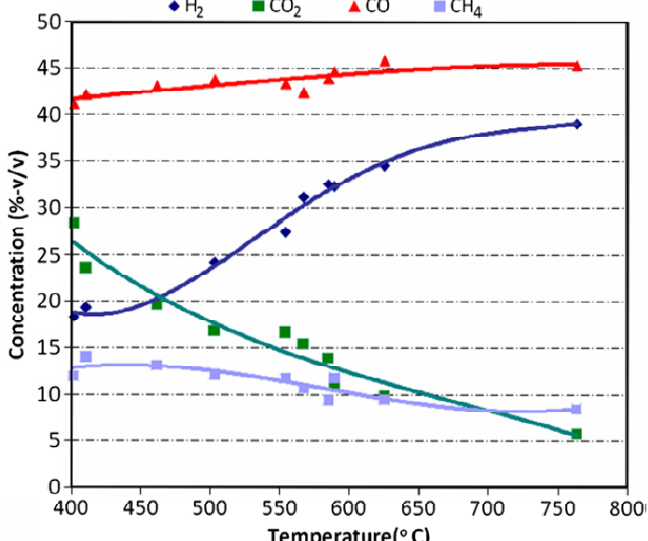
Figure 9. Gas composition of pyrolysis of cotton stalks versus pyrolysis temperature